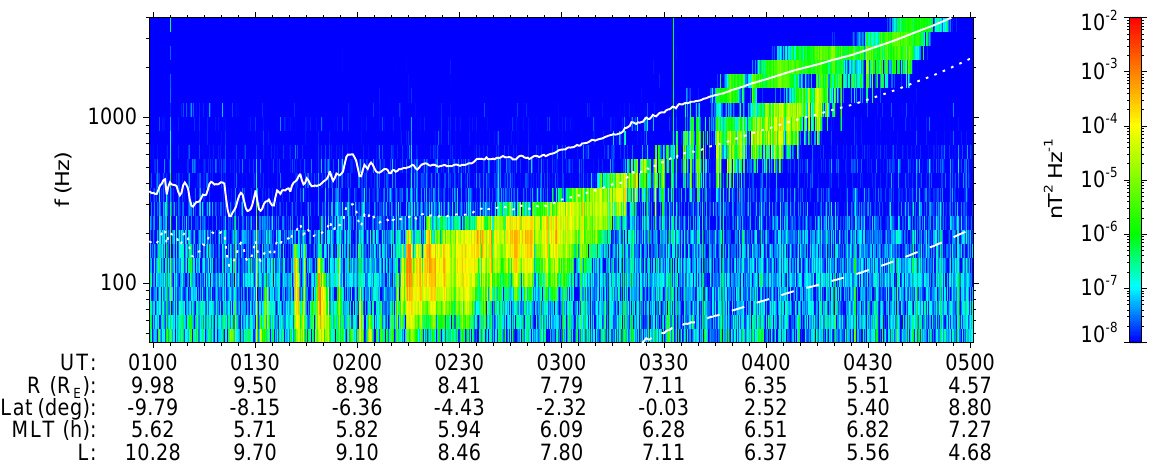
Fig. 1. Power-spectral density spectrogram of the magnetic field fluctuations measured during an inbound orbit on 28 June 2004. The over-plotted white lines reflect different fractions of the local f ce . Solid line: f ce /2; dotted line: f ce /4; dashed line: f ce /42.85 (approximation for the lower hybrid frequency). Spacecraft position is given on the bottom: R-geocentric radial distance; MLat-magnetic dipole latitude; MLT-magnetic local time; McIlwain’s L